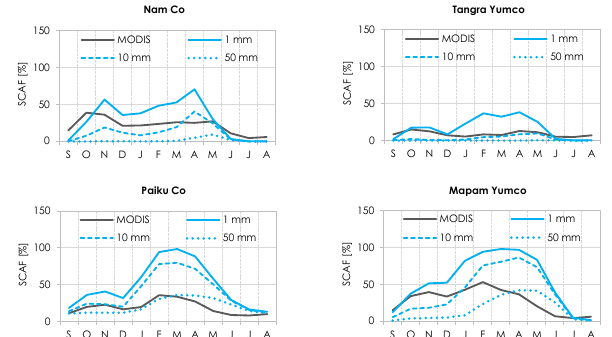
Figure 4. Mean monthly modeled–derived SCAF (blue) using SWE >1mm (solid line), >10mm (dashed line), and >50mm (dotted line) vs. SCAF derived from MODIS (black) for the four study